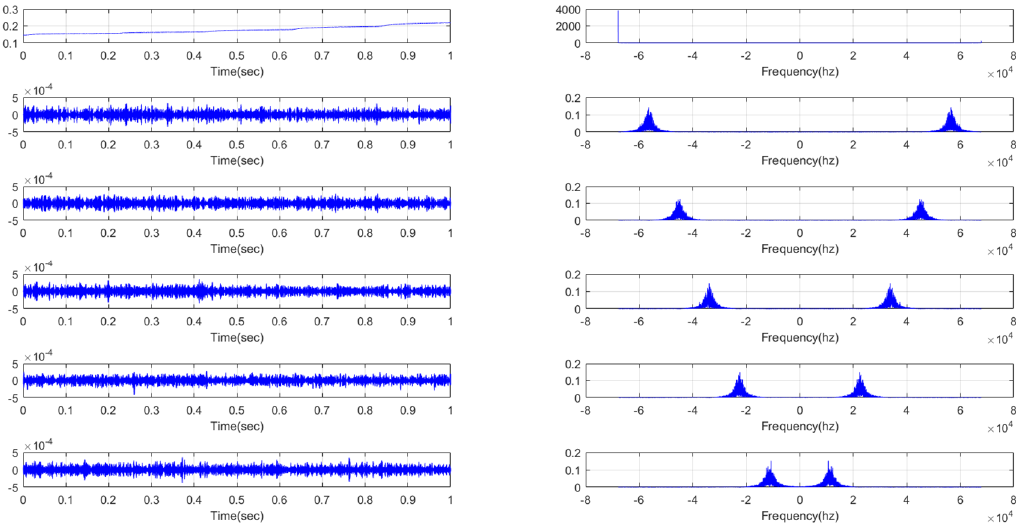
Figure 8. The diagram of VMD decomposition.